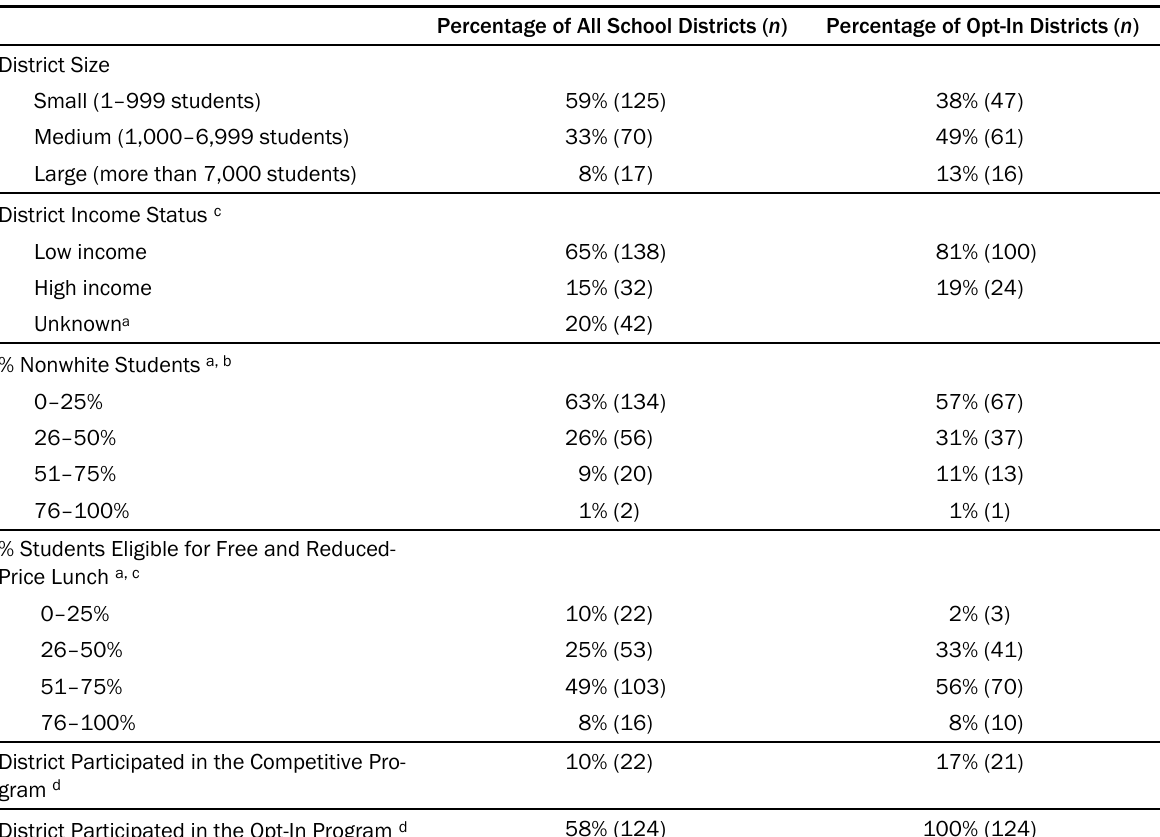
Table 1. Demographic Characteristics of Oregon School Districts ( N =212) and Opt-In Grantee Districts ( N =124) for